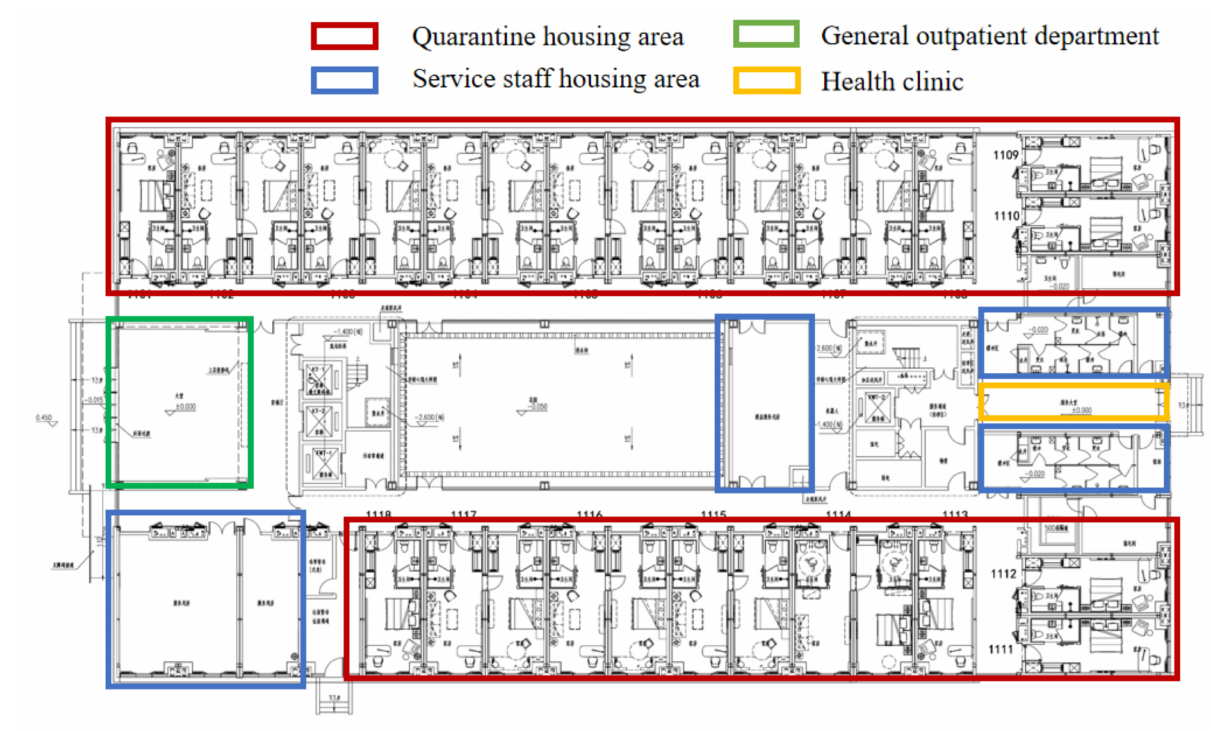
Figure 7. MIC interior floor